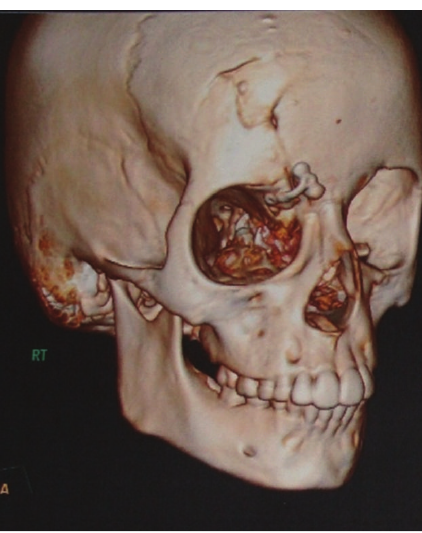
Figure 4: Postoperative 3D CT scan revealing titanium plate and screws intact at the fracture site.